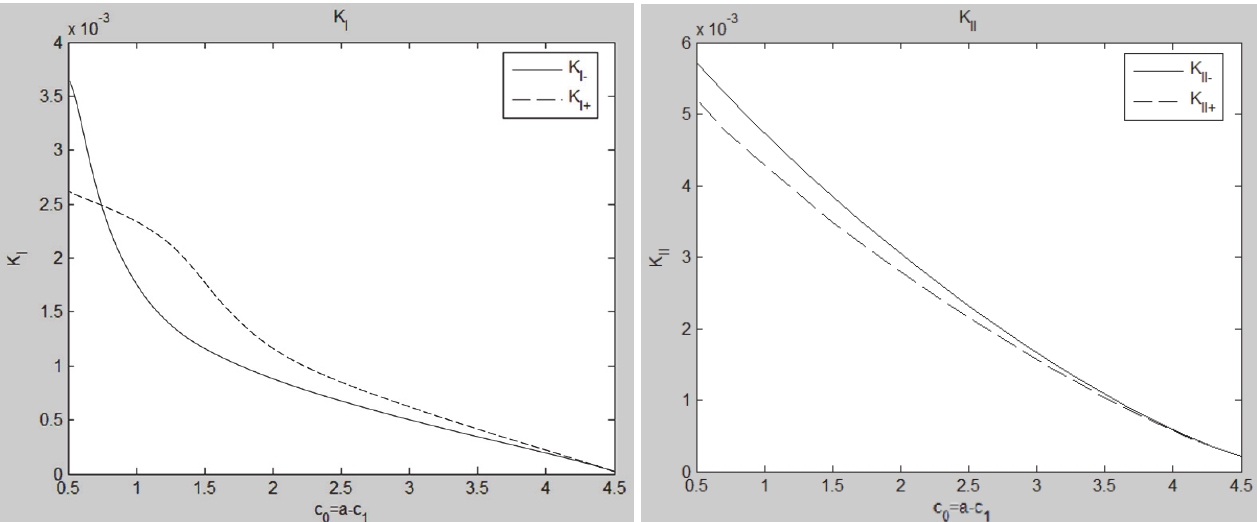
Figure 4: First case: The changing SIF ,